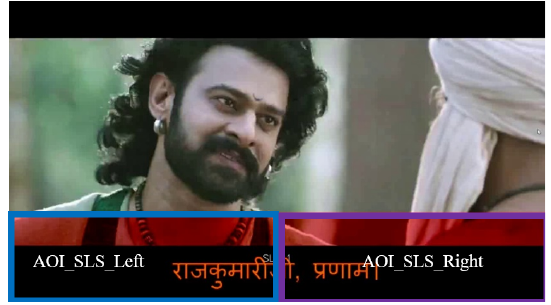
Figure 5: Two parts of the SLS area are second AOI set